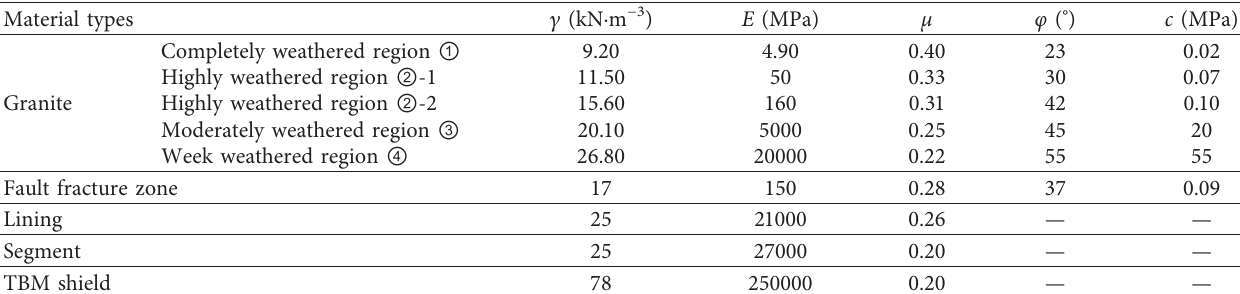
Table 1: Physical and mechanical parameters of